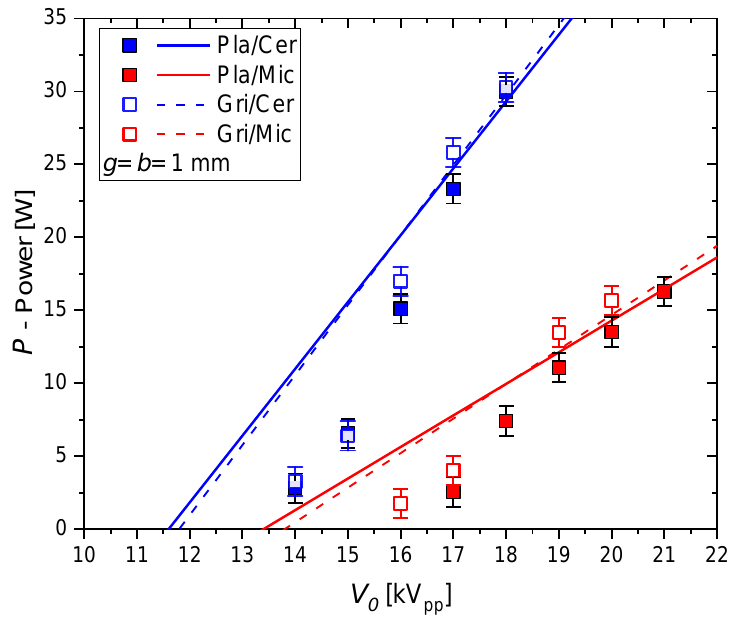
Figure 7. Discharge power measured in pure CO 2 (data points) and calculated (lines) with the classical Manley equation ( β =1; C d and C cell taken from Figure